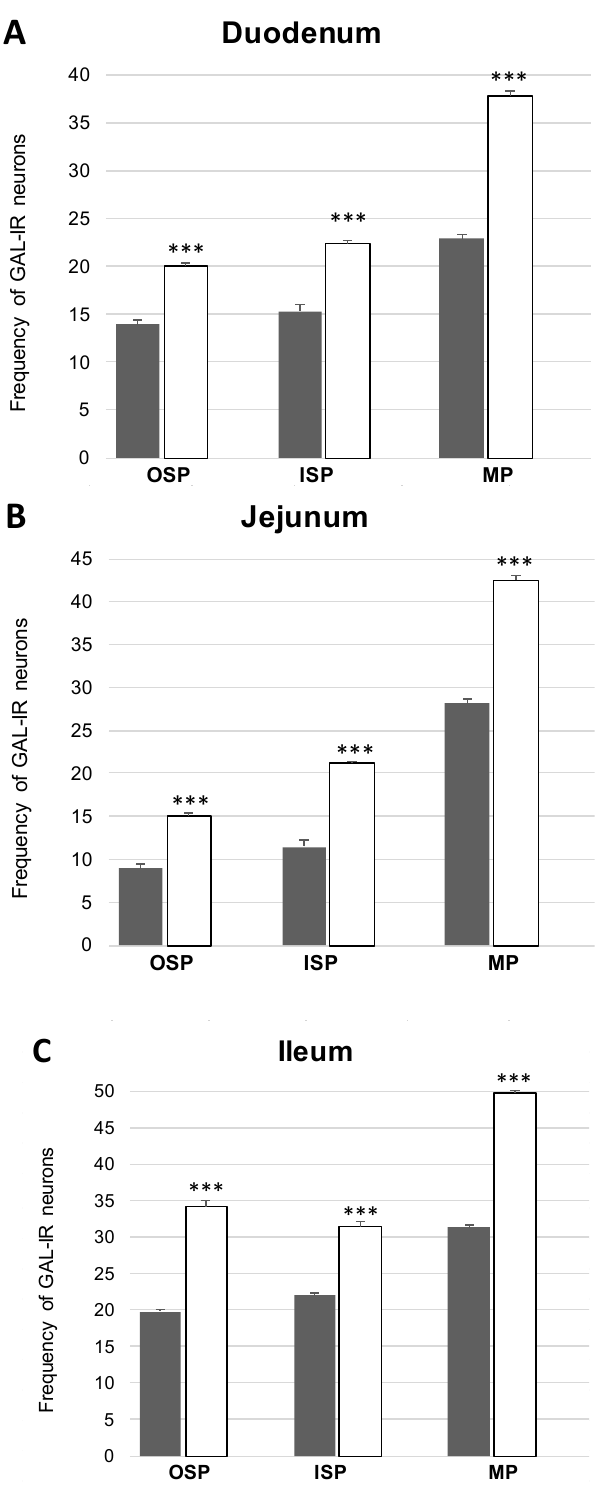
Figure 5. Colocalization of nNOS- positive cell bodies with GAL in inner submucous plexus (ISP), outer submucous plexus (OSP) and myenteric plexus (MP) with galanin (GAL) within the duodenum, jejunum and ileum in the control and experimental groups. Mean ( ± SEM) percentage of neurons immunoreactive to nNOS and GAL in the MP- myenteric plexus, OSP- intestinal outer submucous plexus, ISP- intestinal inner submucous plexus in the duodenum ( A ), jejunum ( B ) and ileum ( C ). Control (grey bars), experimental (white bars), *** p < 0.001—indicate differences between control and experimental